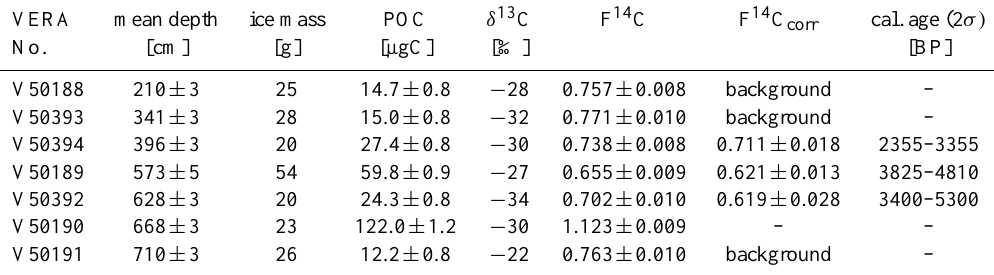
Table 2. F 14 C and δ 13 C data of particulate organic carbon (POC) determined in ERW ice core samples. All samples have a length of about 5cm (except V50189 with 10cm). Along with the analyzed POC mass, isotope ratios are reported as δ 13 C and F 14 C (fraction modern carbon; Reimer et al., 2004), respectively. The background corrected 14 C data, F 14 C corr , assume a uniform background contribution estimated by the average of the samples V50188, V50393 and V50191 (note that the given uncertainties refer to analytical errors only). The calibrated radiocarbon age (calculated with O × Cal 4.1) refers to the 2 σ – probability range.